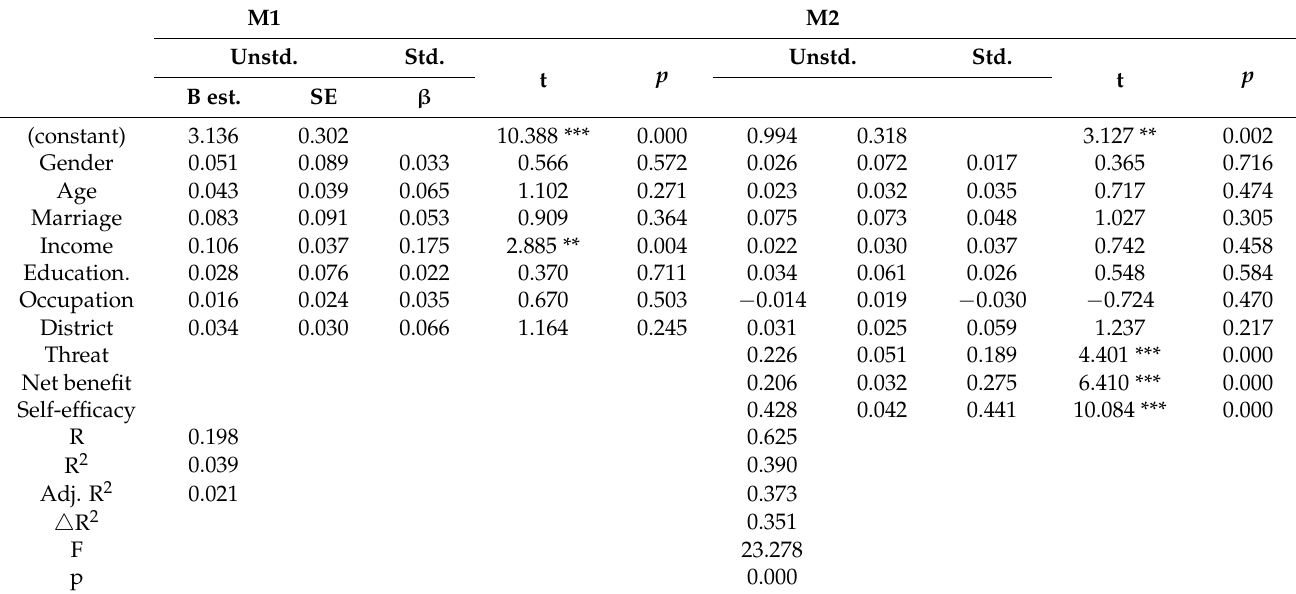
Table 4. Associations of variables.